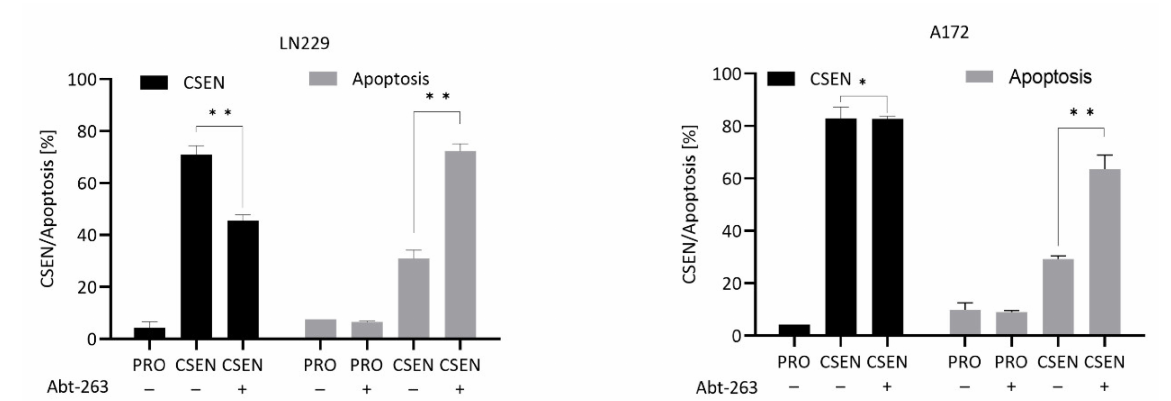
Figure 3. Effect of ABT-263 on senescent cells. Treatment of senescent LN229 cells with ABT-263 leads to a significant decrease in senescence and an increase in apoptosis. In A172 cells, reduction in senescence was not observed, while apoptosis increased significantly. PRO, proliferating cells; CSEN, senescent cells. Data represent mean of >3 independent experiments ± SEM. * p < 0.05, ** p < 0.01.